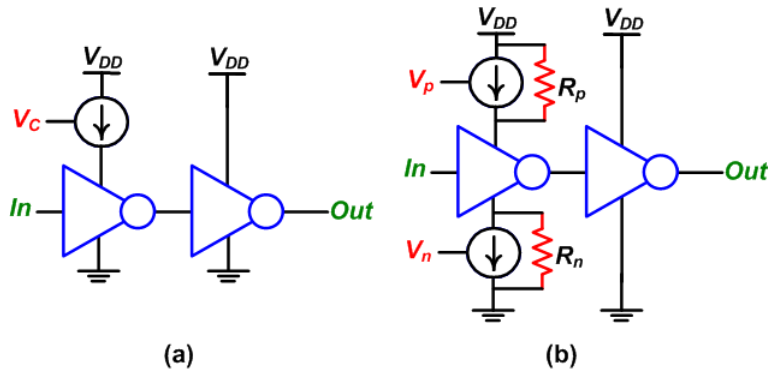
Figure 7. Inverter based digital delay lines. (a) Rise time control, reproduced from [18], and both rise and fall time control, reproduced from